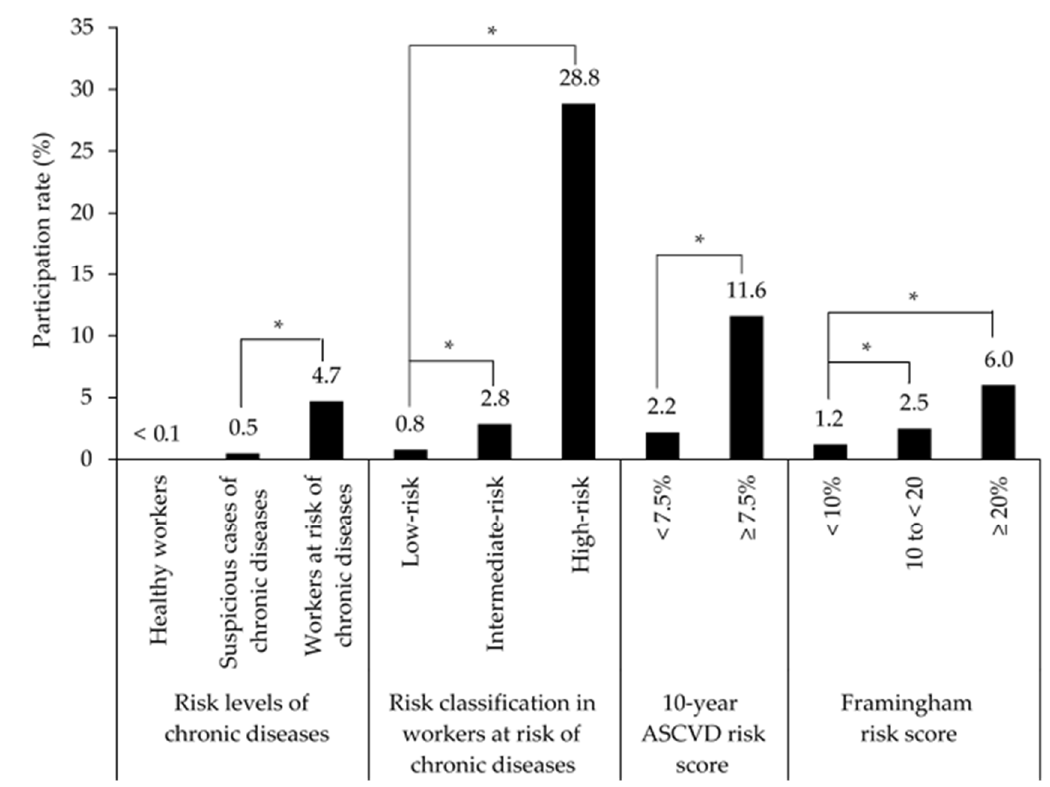
Figure 1. Participation rates for health promotion programs in health risk groups among employees of the semiconduc- tor/liquid crystal display (LCD) company. ASCVD, atherosclerotic cardiovascular disease. * p < 0.001.